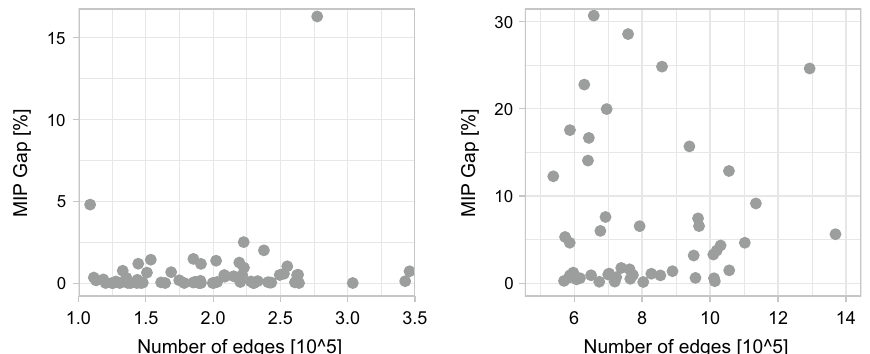
Fig. 4 The MIP gap as a function of the number of edges in medium ( left ) and large instances ( right ). Depicted are 64 medium and 50 large instances, including those solved to optimality. Be aware of the differently scaled